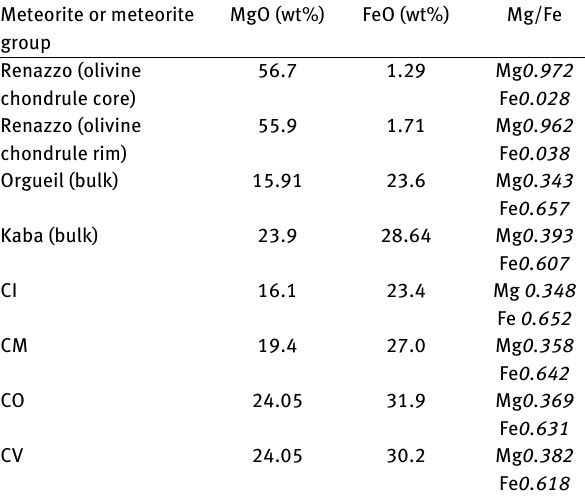
Table 1. The FeO and MgO abundance, and Mg/Fe ratio of various meteorites and groups. Data taken from Sztrókay et al.